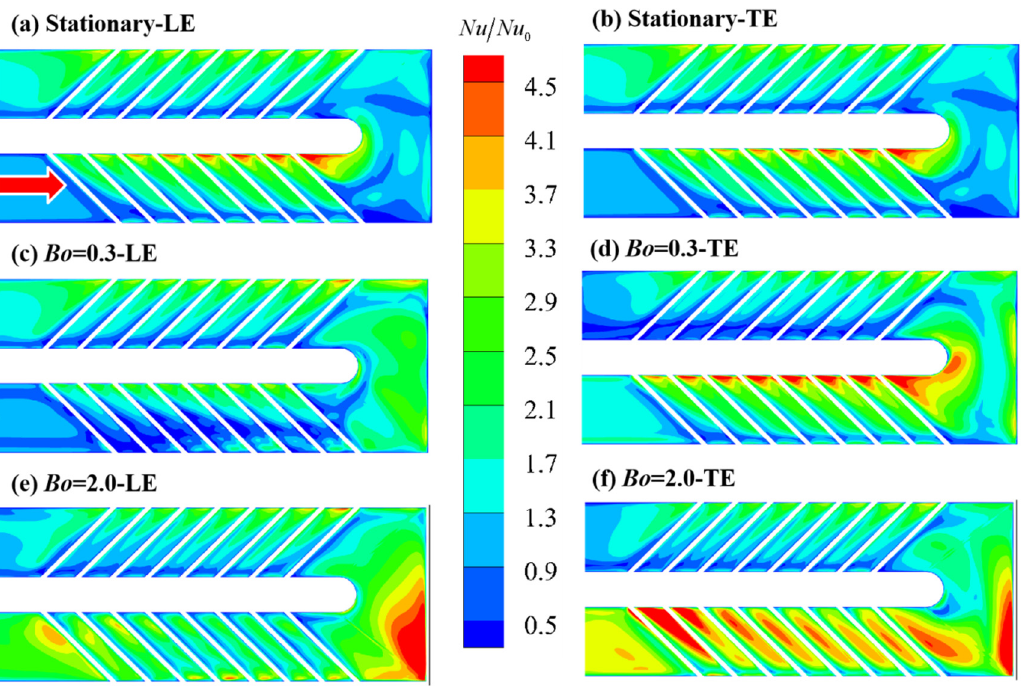
Figure 14. Nu / Nu 0 contour of ribbed channel.